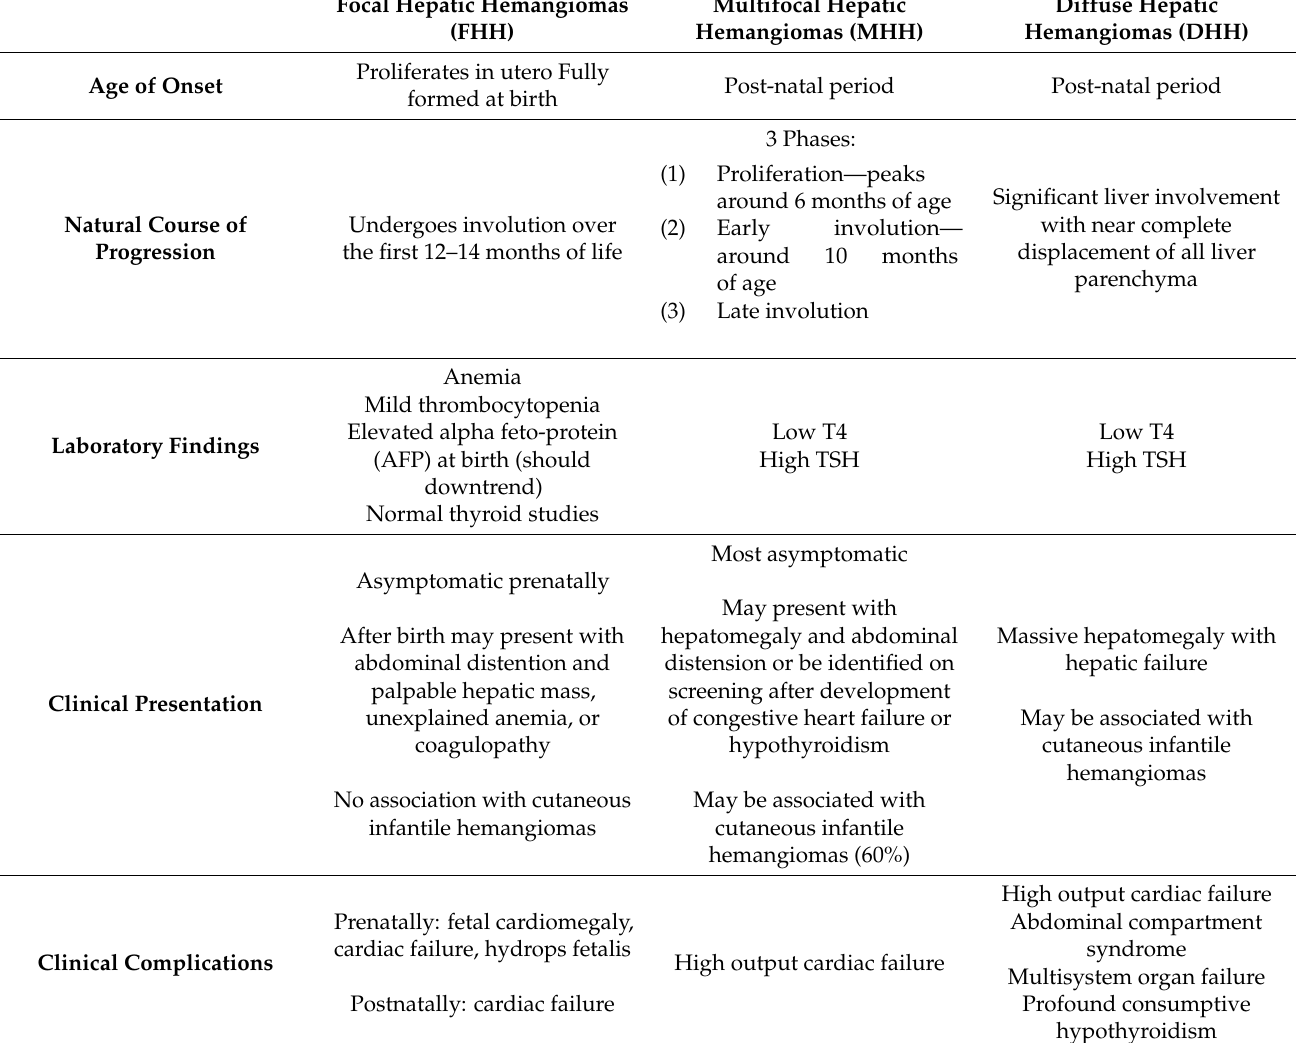
Table 1. Infantile Hepatic Hemangiomas—Clinical